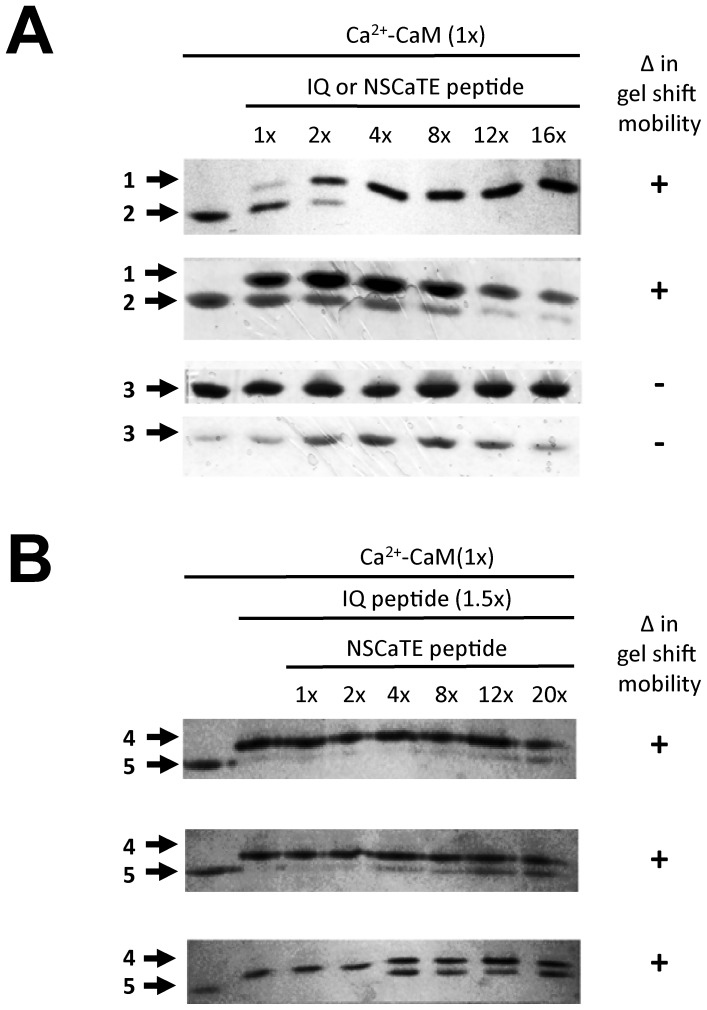
Gel Mobility Shift Assays illustrate that snail NSCaTE of LCav1 and mammalian NSCaTE of Cav1.2 can displace calcium-calmodulin (Ca2+-CaM) prebound to either snail IQ or mammalian IQ motifs.Gel shift mobility assays of CaM and individual peptides (A) or CaM pre-bound to an IQ peptide competing with increasing amounts of NSCaTE (B). Each lane contains 300pmol wild-type Ca2+-CaM; first lane is a CaM-only control for reference (Positions #2,#3,#5). (A) Each subsequent lane has increasing ratios of C-terminal (IQ) and/or N-terminal NSCaTE peptides at the ratios indicated. The changing conformation of CaM by IQ peptide causes a mobility shift of the CaM band (from Positions #2 → #1, top panels). Neither snail NSCaTELCav1 or mammalian NSCaTECav1.2 changed CaM mobility alone, at any ratio (Position #3, bottom panels). (B) First lane is again Ca2+-CaM-only control (Position #5). Second lane is Ca2+-CaM with 1.5×IQ peptide alone control (for the maximum shift reference, Position #4). In subsequent lanes, increasing the amount of added NSCaTE peptide eventually reversed the slow mobility of CaM-IQ peptide back to the faster mobility of CaM without IQ peptide (Position #4 → #5), but not at a 100% effectiveness.